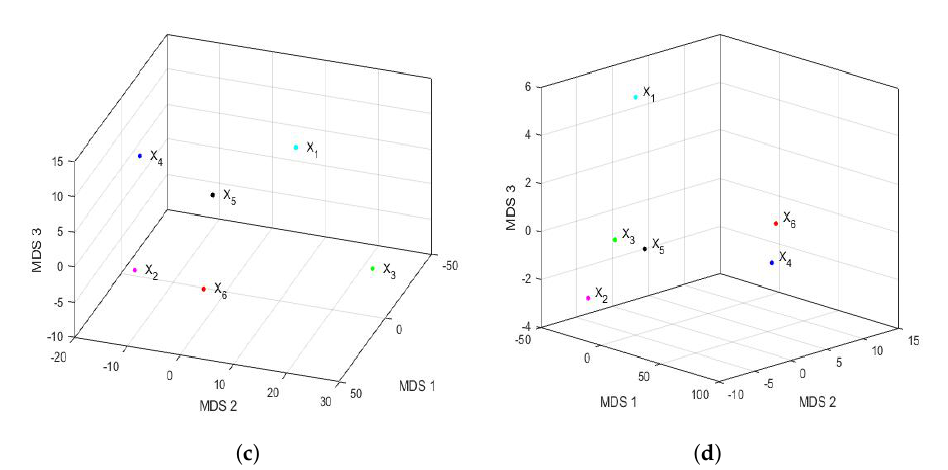
Figure 22. First three principal coordinates of the feature vectors by trimesters of each of the years of the 2015–2020 six-year term: X 1 (2015), . . ., X 6 (2020). ( a ) Feature vectors: first 3 principal coordinates of the first trimester. ( b ) Feature vectors: first 3 principal coordinates of the second trimester. ( c ) Feature vectors: first 3 principal coordinates of the third trimester. ( d ) Feature vectors: first 3 principal coordinates of the fourth